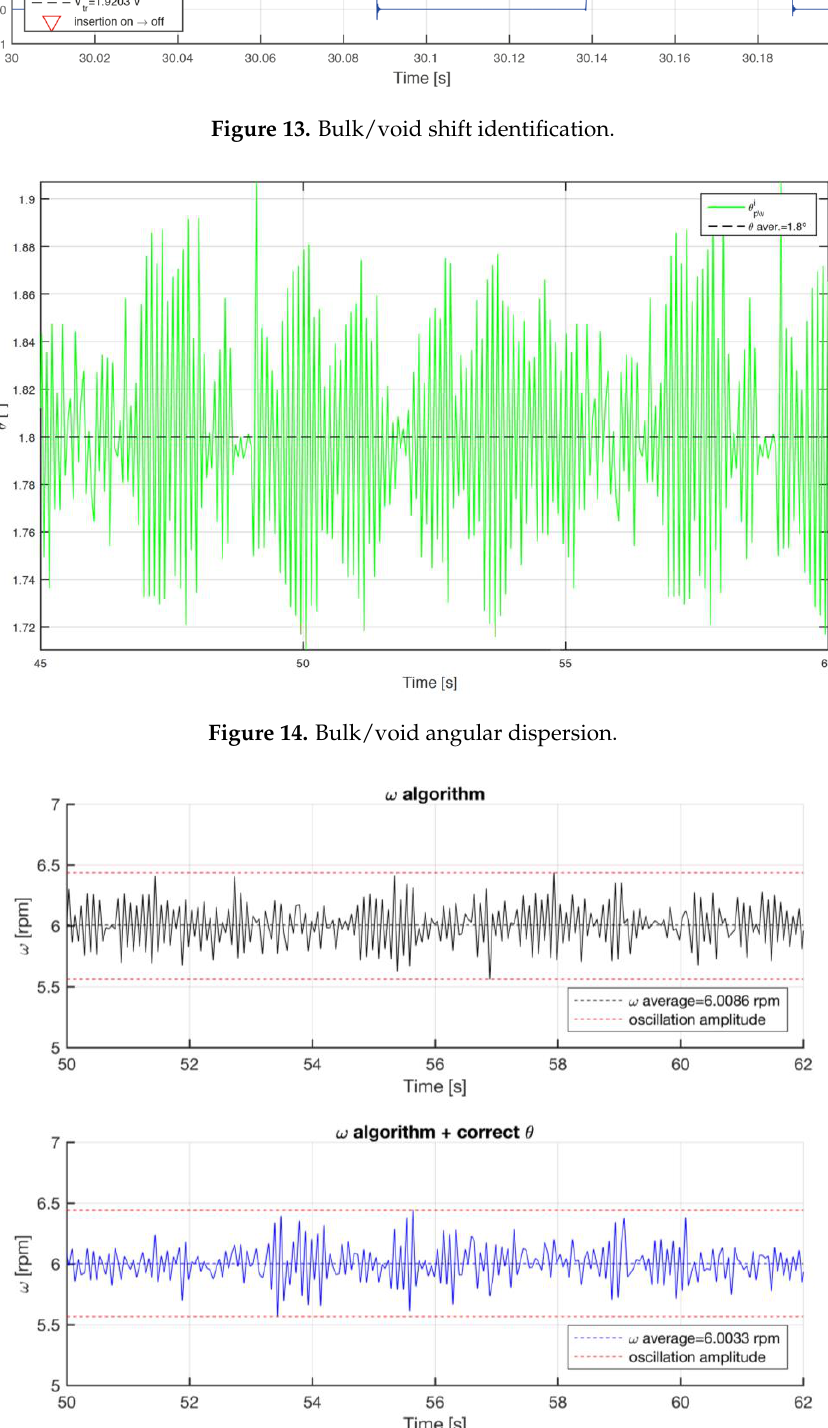
Figure 15. Angular speed correction algorithm results: raw angular speed vs correct angular speed.